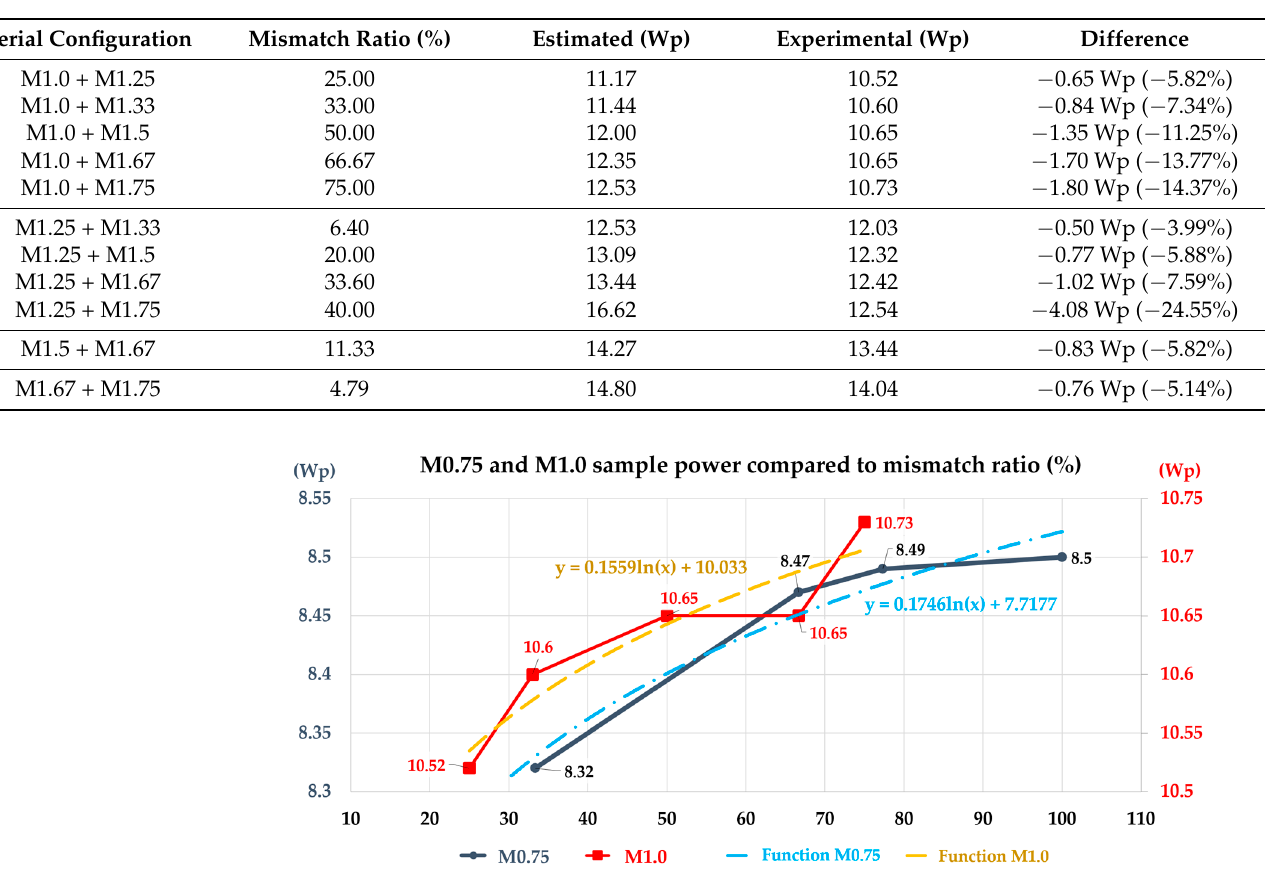
Table 11. The difference between the estimated and experimental value in each case II ( ≥ M1.0). Figure 11. Chart of the difference rate compared to the electrical mismatch ratio.